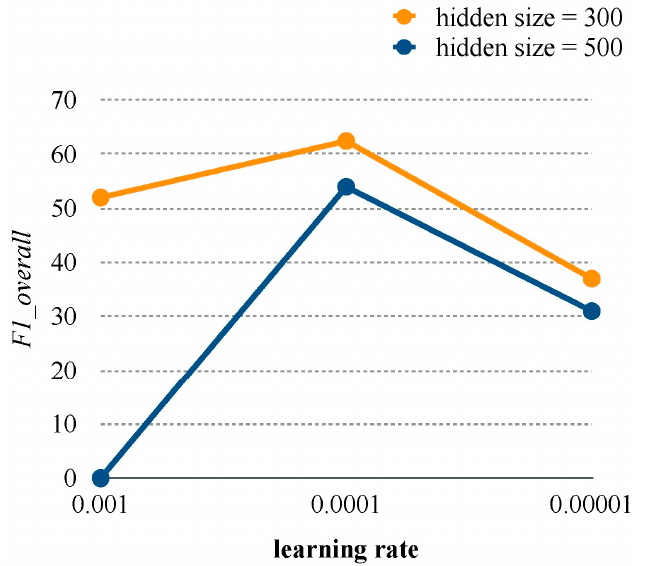
Figure 4. The validation set results for the HSAN under different learning rates and hidden layer sizes. The current study compared the performance for the validation set between the squashing function in the HSAN and the SoftMax function in the HAN. The results indicate that the squashing function in the attention mechanism can achieve superior classification performance to the SoftMax function in the HAN (e.g., the squashing function had an 11.87% higher F 1 overall value than the SoftMax function did). In addition, the paper also applies the squashing-attention to the non-hierarchical model, such as the GRU(Squashing) model, the difference between GRU(Soft) and GRU(Squashing) in the F 1 overall is 5.82%, the difference between HSAN and GRU(Soft) in F 1 overall is 6.25%, and the different between HSAN and GRU in F 1 overall is 26.54%. Table 7 presents a comparison between the hierarchical and nonhierarchical structures when using the squashing-attention and soft-attention